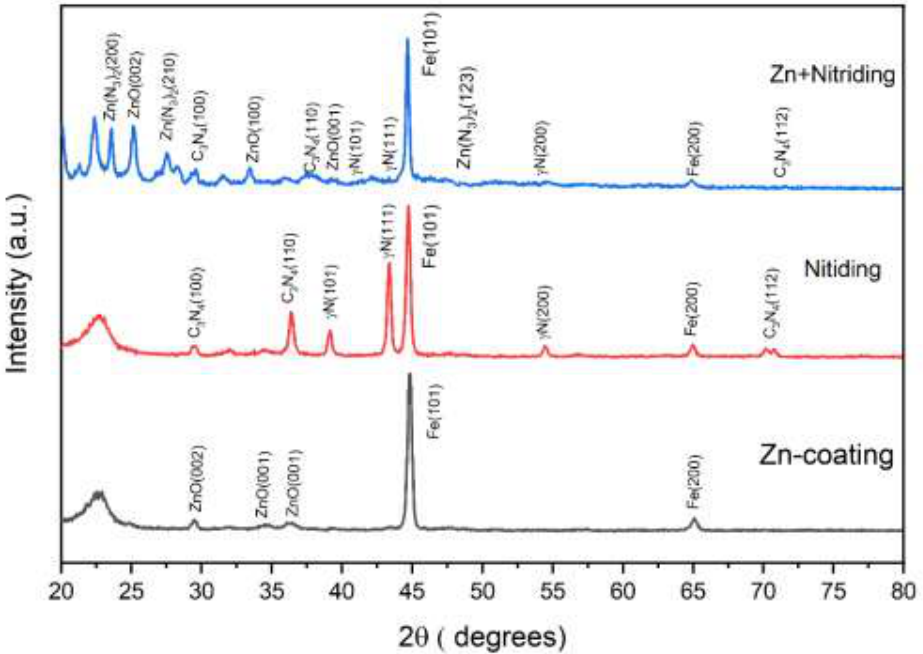
Figure 1: The XRD pattern of an HSLA steel substrate with various surface